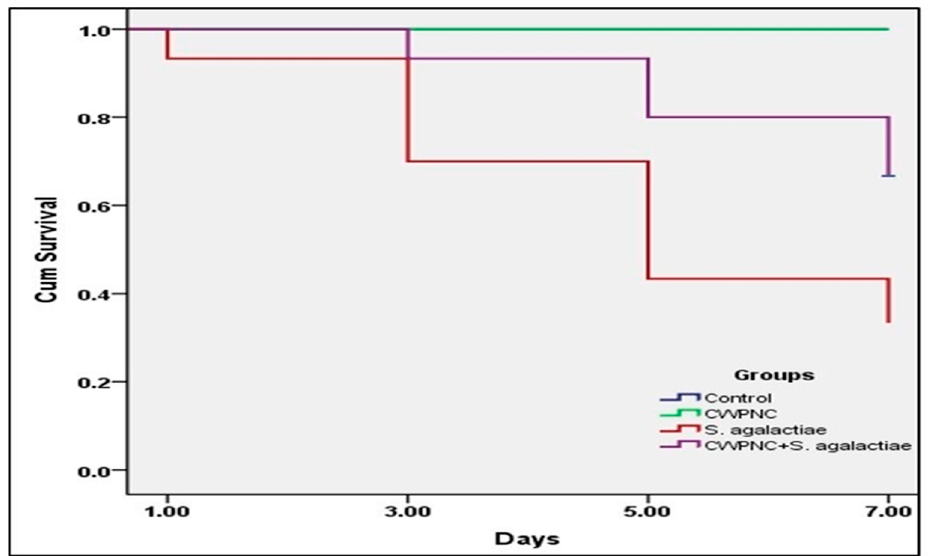
Figure 2. Effect of CWPNC as water exposure on clinical observation of experimentally infected O. niloticus with S. agalactiae for 7 days. ( A ) Fish in the control group or CWPNC group demonstrated normal appearance. ( B , C ) Fish in the S. agalactiae group showed skin ulcers (blue arrows), hemorrhagic patches on the body, and fin rot (yellow arrows). ( D ) Fish in the CWPNC + S. agalactiae group showed some fin rot (yellow arrow).